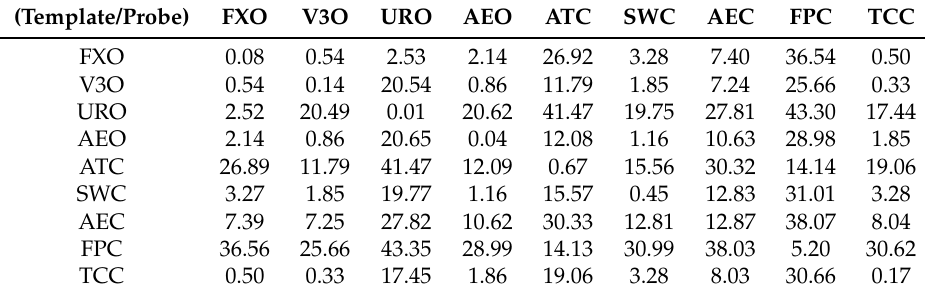
Table 4. EER (%) produced by the VeriFinger system.